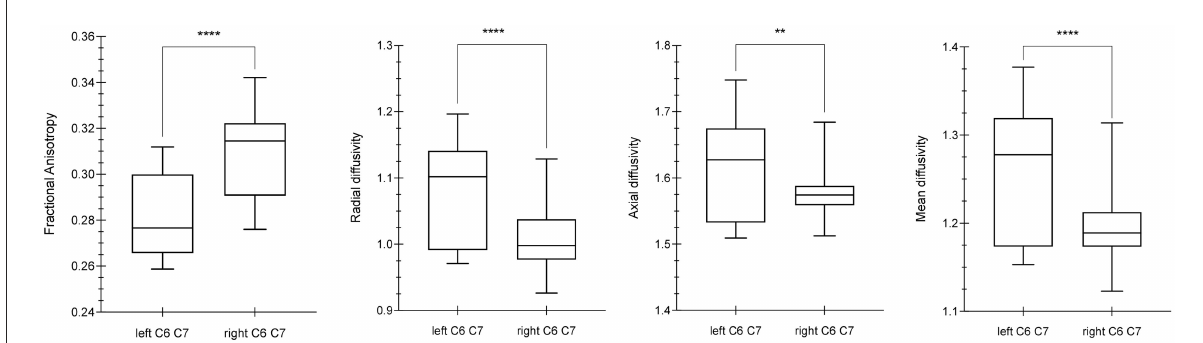
FIGURE1 Differences between diffusion parameters in the left and right C6–C7 roots. By using the Mann Whitney U-test (MWUt), significant statistical differences were demonstrated in FA (p-value < 0.0001, MWUt = 792), RD (p-value < 0.0001, MWUt = 1,286), AD (p-value < 0.0033, MWUt = 1,861), and MD (p < 0.0001, MWUt = 1,563). The p-value lower for AD than RD suggests a minor axonal damage in comparison with dysmyelination process. **, ****indicate p -values significant.